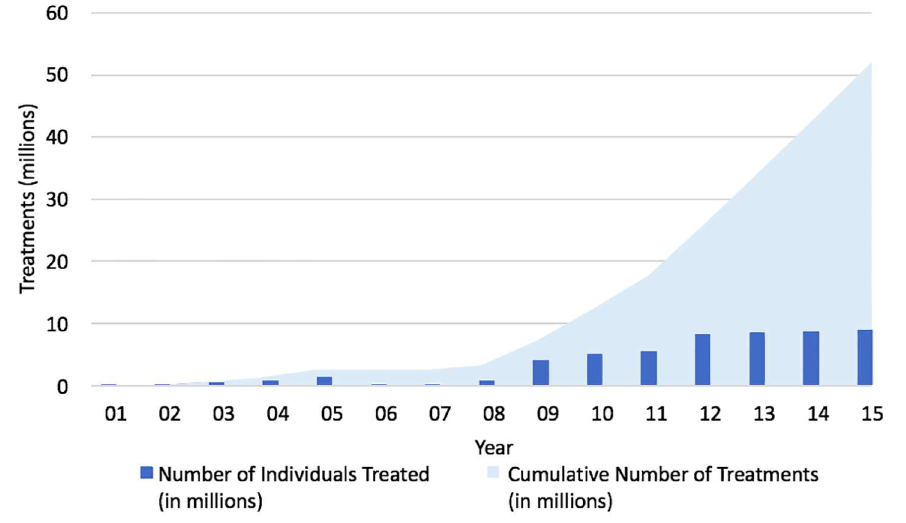
Fig 2. Number of people treated and cumulative number of treatments given by program